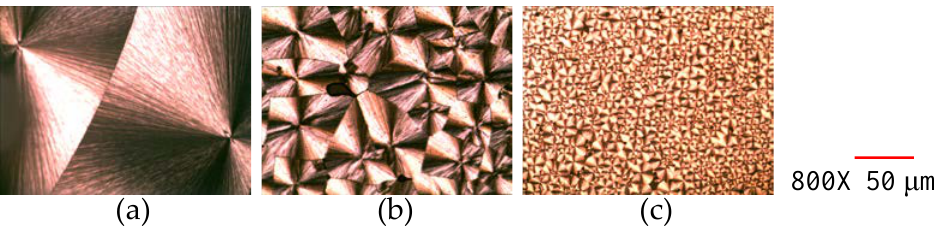
Figure 6. Spherulite morphologies of PESu/h-BN composites when crystallized at 50 °C. The PESu/h-BN compositions are: ( a ) 100/0; ( b ) 99/1; and ( c ) 97/3.